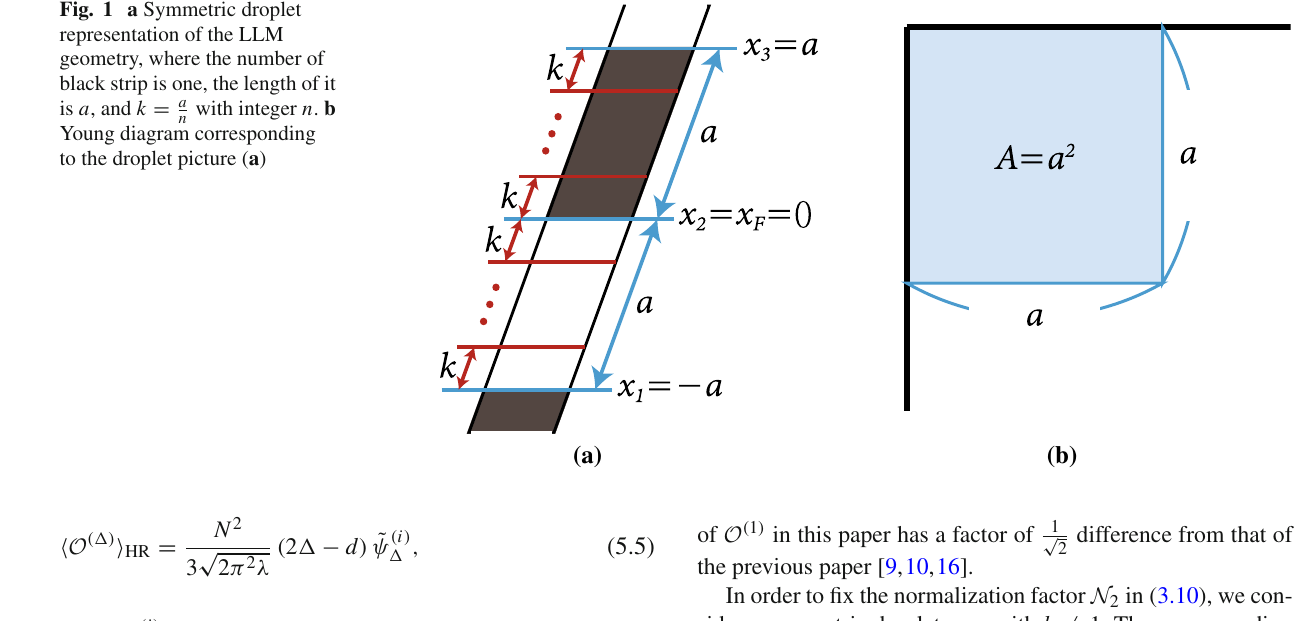
Fig. 1 a Symmetric droplet representation of the LLM geometry, where the number of black strip is one, the length of it is a , and k = a with integer n . b n Young diagram corresponding to the droplet picture ( a